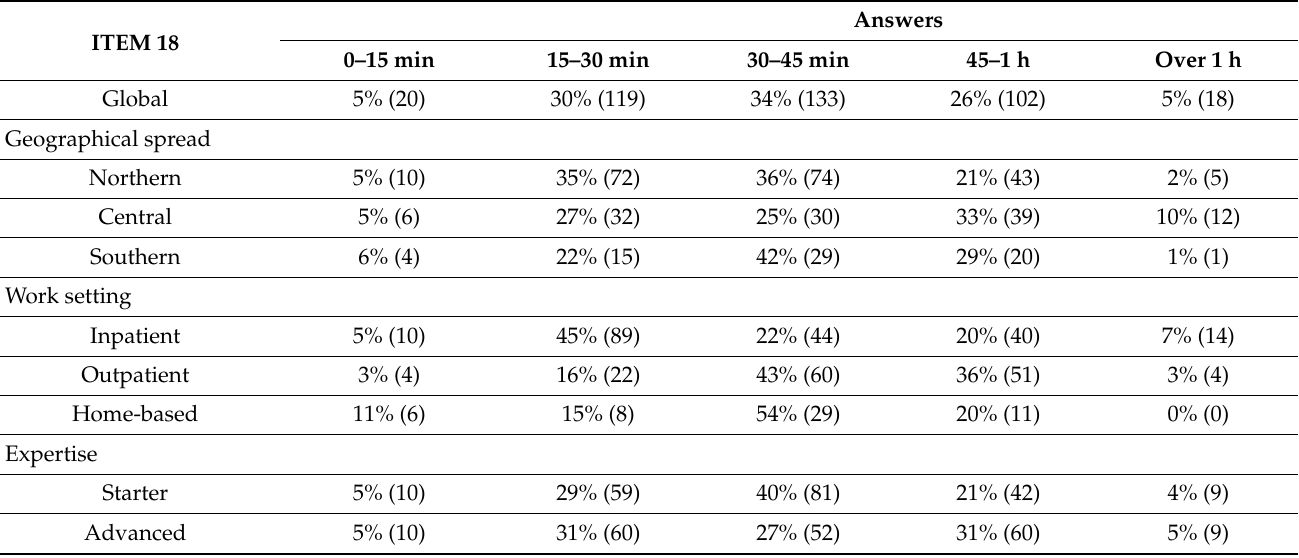
Table 5. Answers referred to item 18: How long does an average physiotherapy session last for this type of patient in the acute phase (48–72 h) in the place where you